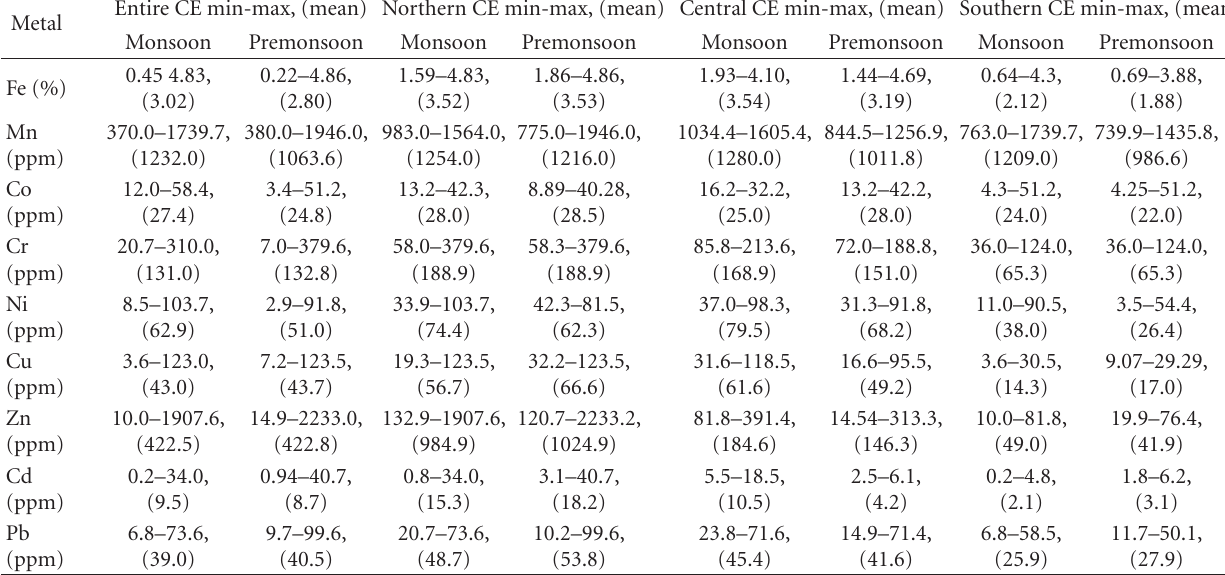
Table 3: Trace metals levels in di ff erent regions of the Cochin estuary